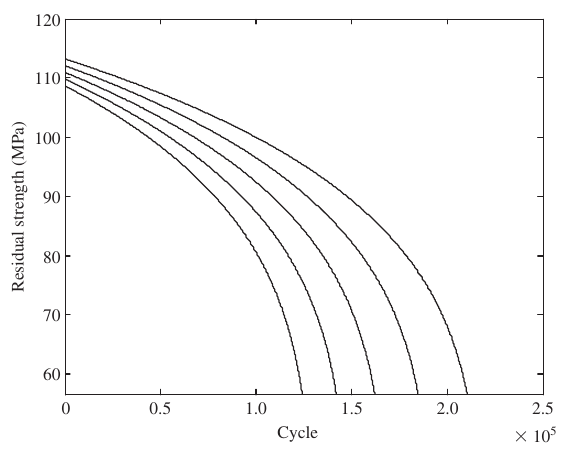
Figure 1 Typical expression of strength degradation of G1/Ep laminate [15] by Yang ’ s equation [11, 12] , with distributed ( ± 45) S static strengths under constant-amplitude maximum cyclic stress S = 56.6 MPa.